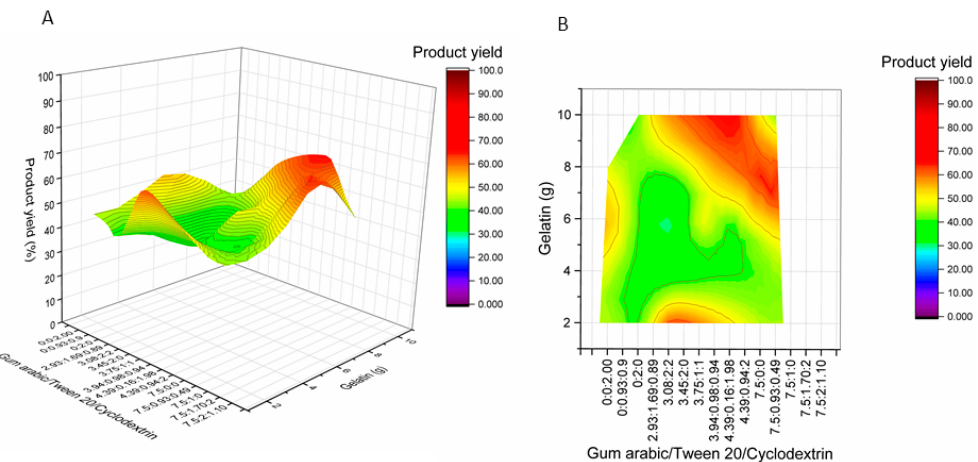
Figure 2. Influence of wall material component (gelatin supplemented with gum Arabic, Tween 20, and β -cyclodextrin) amounts on product yield of oregano microcapsules. RA—rosmarinic acid, CA—carvacrol, EE—encapsulation efficiency. ( A )—surface plot, ( B )—contour plot.